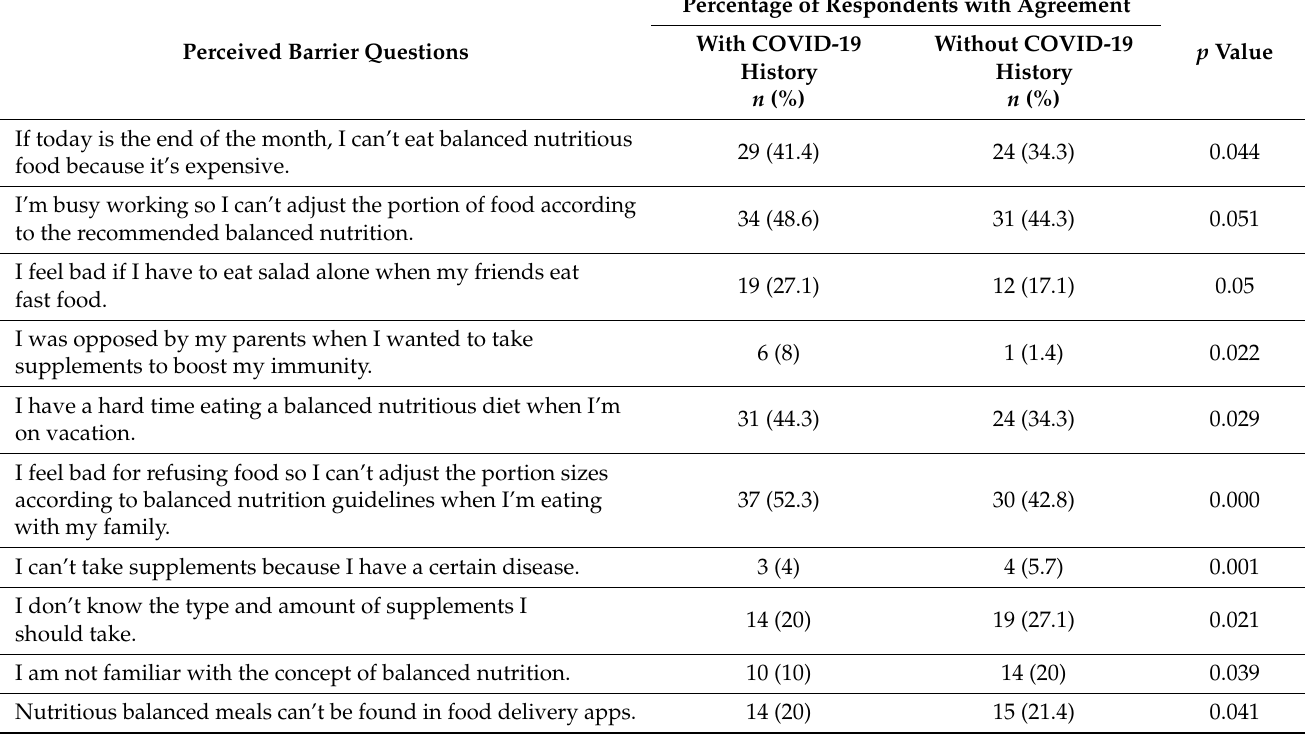
Table 5. Perceived barrier